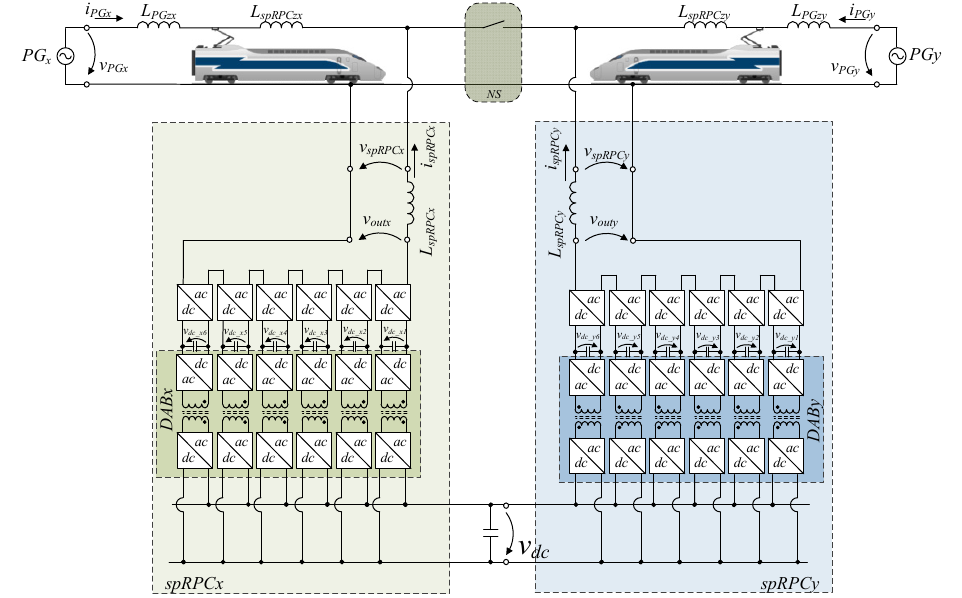
Figure 3. Simpli fi ed schematic of the proposed topology for the sp ‐ RPC, highlighting the Figure 3. Simplified schematic of the proposed topology for the sp-RPC, highlighting the measure- measurement points for the variables involved in the control algorithms. ment points for the variables involved in the control algorithms. For the correct operation of sp ‐ RPC, the entire algorithm must present a given sequence of data processing, as well as identify the interaction of variables between di ff erent blocks of data processing. Figure 4 shows the main implemented control algorithms, highlighting the input and output variables. Nevertheless, it is possible to verify a sequence of data processing, starting with the acquisition of instantaneous voltage and current values from di ff erent points of the sp ‐ RPC, going through to determine the average values of both voltage and power required. Then, based on the combination of average and instantaneous values with speci fi c control functions, it is possible to determine the reference operating powers for each sp ‐ RPC side, the spRPCx and spRPCy . These values are later used to adjust the control signals in order to minimize operating errors compared to the reference values. α y1 … … .. .. α y6